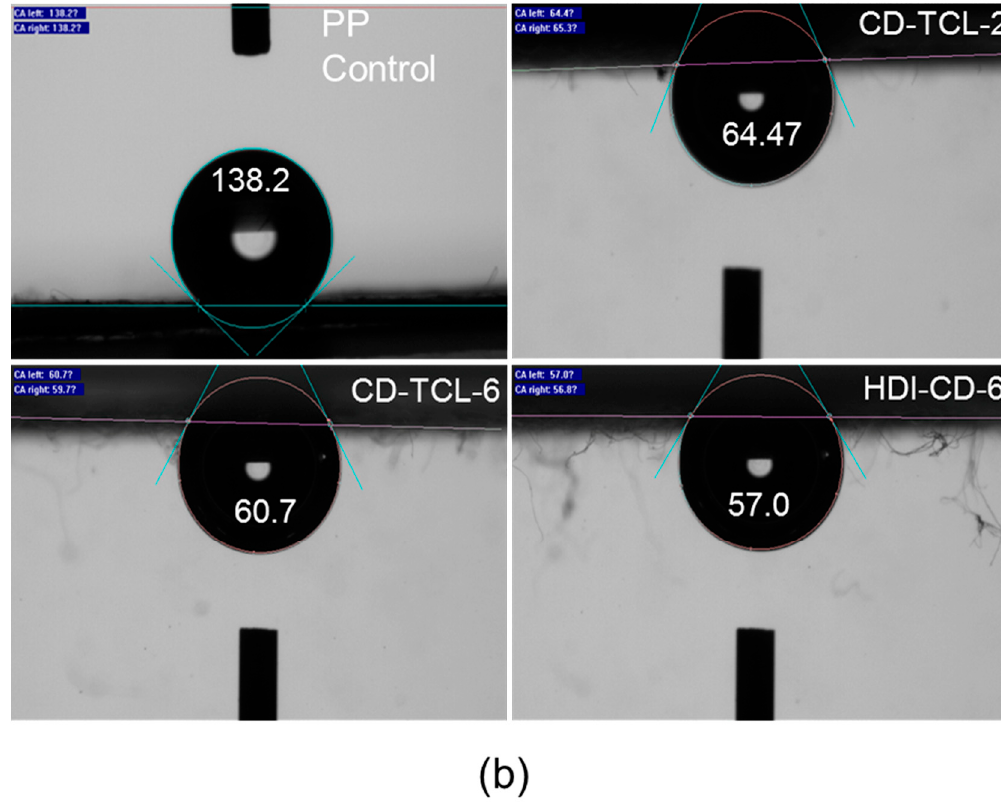
Figure 6. ( a ) Contact angles measured by sessile drop method and captive bubble ( b ) average contact angle drops, PP control (sessile drop), triclosan-loaded CD-TCL-2, triclosan-loaded CD-TCL-6 and CD-grafted HDI-CD-6. Data for each sample are expressed as an average of five measurements ( n = 5). Statistical differences are indicated with (***) for p < 0.001 and (**) for p < 0.01.